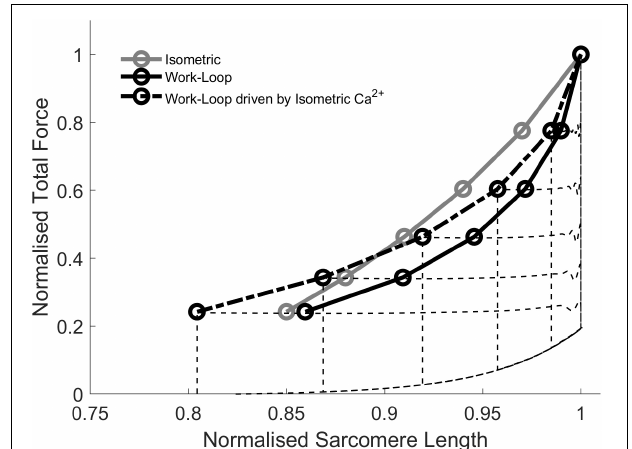
FIGURE 6 | Simulations of work-loops driven by Ca 2 + transients generated from isometric contractions. The isometric and work-loop ESFLR are replotted from Figure 4 . Driving work-loops with Ca 2 + transients generated from force-equivalent isometric contractions leads to a left-ward shift of the work-loop end-systolic force-length relation (ESFLR; dashed line) but it does not superimpose on the isometric